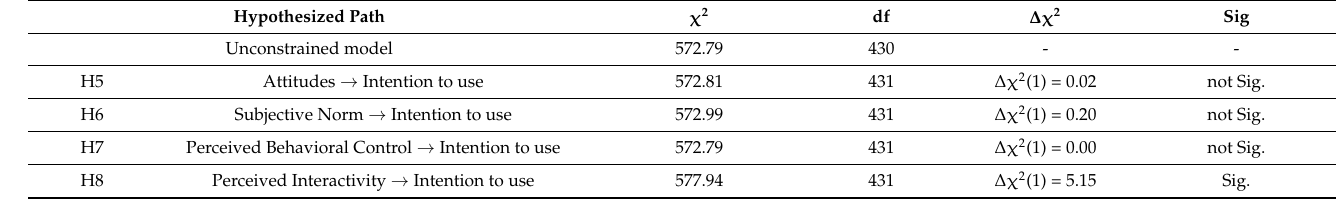
Table 7. Verification results of Hypotheses 5–8 from multigroup SEM